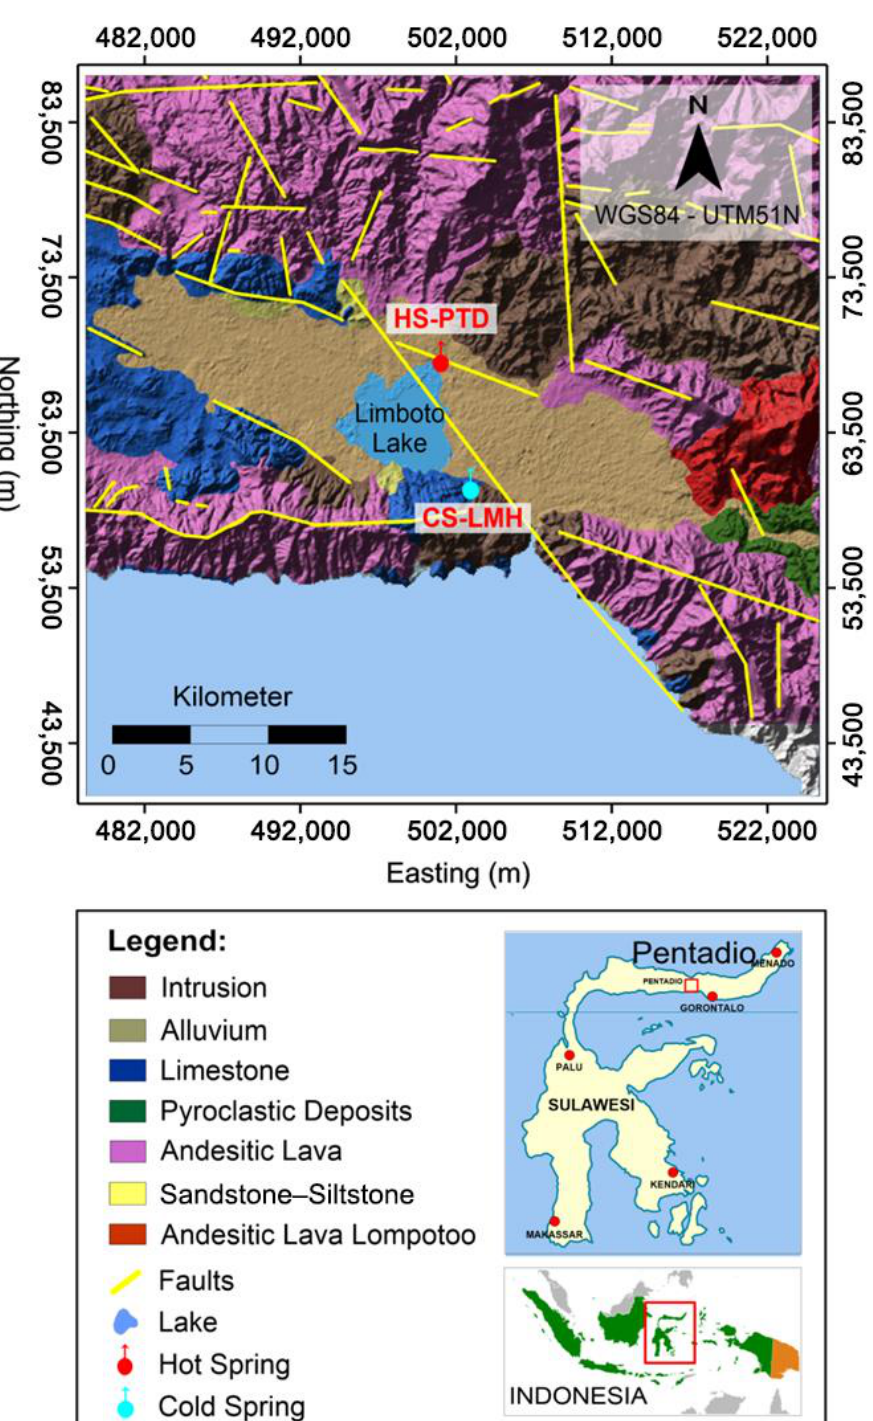
Figure 1. Geological map of Gorontalo in the northern arm of Sulawesi Island. The Limboto Lake — Pentadio area, the complex of hot springs (red dot), and the cold spring (blue dot) are located inside the white box (modified from Kavalieris et al., 1992; Sompotan, 2012). Fault System of Limboto Lake — Pentadio The faults and fractures mapped in the area are normal faults and lineaments, which are difficult to identify. In general, the fault structures have relatively W – E- and north- west – southeast (NW – SE)-trending orientations, as depicted by the rose diagrams in Fig-